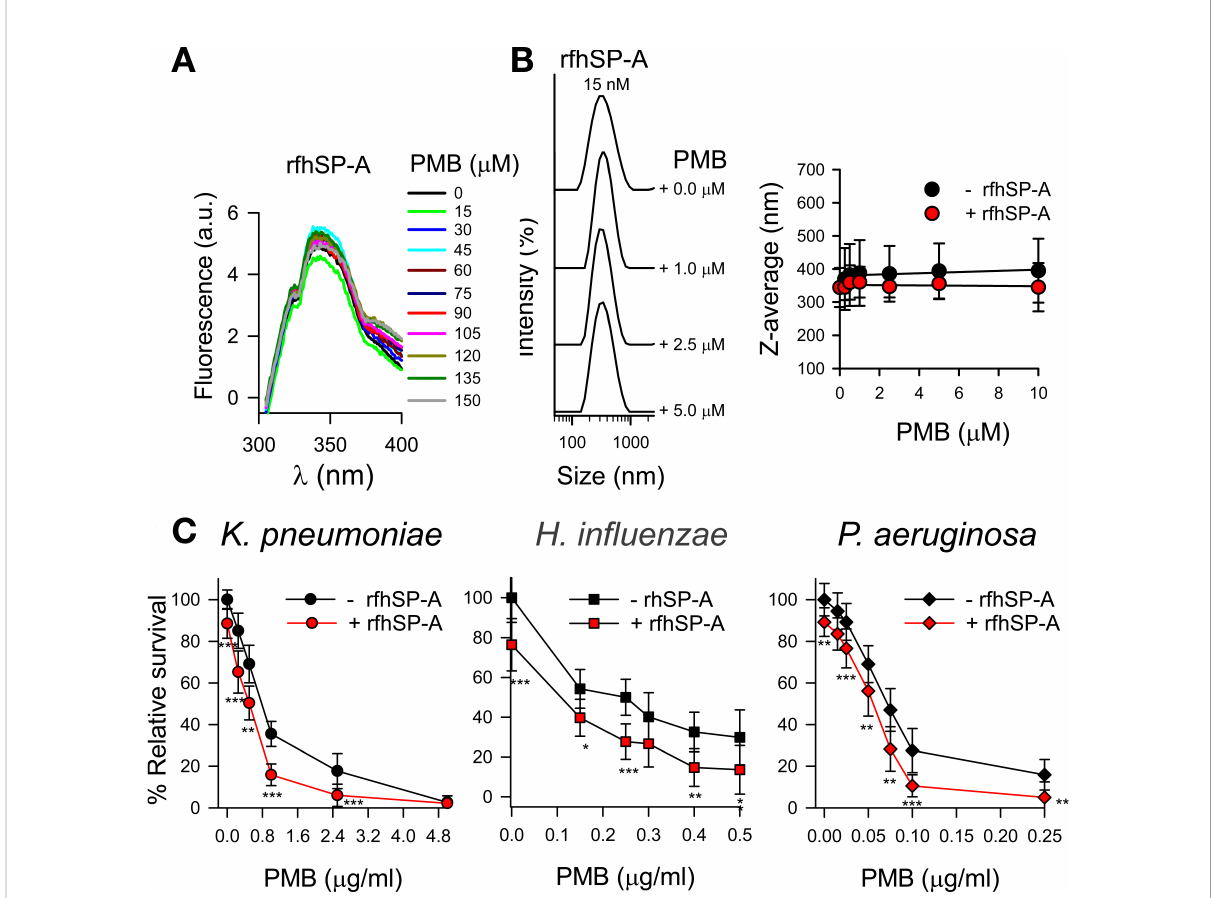
FIGURE 12 rfhSP-A does not interact with PMB and in combination with PMB increases the killing of Gram-negative bacteria. (A) Tryptophan fl uorescence emission spectra of rfhSP-A (13 m g/ml) were measured with or without increasing concentrations of PMB (0-150 m M; 0-180 m g/ml) at 25°C in 5 mM Tris-HCl buffer (pH 7.4) containing 150 mM NaCl. Samples were excited at 295 nm and the emission spectra recorded from 300 to 400 nm. One representative experiment of four is shown. (B) (Left) Addition of increasing concentrations of PMB (ranging from 0 to 5 m M) to a solution containing a constant concentration of rfhSP ‐ A (17.5 nM) in 5 mM Tris-HCl, 150 mM NaCl, buffer (pH 7.4) did not change the particle size of either SP ‐ A or PMB. One representative experiment of four is shown. (Right) Dependence of Z-average on the PMB concentration in the presence or absence of rfhSP-A (17.5 nM). (C) 10 5 CFUs/ml of bacteria ( K. pneumoniae , NTHi, and P. aeruginosa O1) were incubated with different concentrations of PMB in the absence or presence of rfhSP-A (1 m g/ml) (17.5 nM) in 10 mM phosphate, 1% TSB, and 100 mM NaCl buffer (pH 7.4) for 1 h at 37°C. Bacteria were then plated on LB agar ( Kp and PAO1) or sBHI agar (NTHi) for CFU counting. Results are shown as a percentage of relative survival compared to untreated bacteria. The results in (A) and (B) correspond to rfhSP-A treated with polymyxin agarose in 5 mM Tris, 150 mM NaCl, pH 7.4 buffer to remove LPS contamination. In (C) , experiments were performed with both polymyxin-agarose treated and untreated rfhSP-A, with identical results. Data are means ± SD of three independent experiments, each in triplicate. Results were statistically analyzed by Student ’ s t-test. * p < 0.05, ** p < 0.01, and *** p < 0.001 when bacteria treated with rfhSP-A+PMB were compared with bacteria treated with PMB